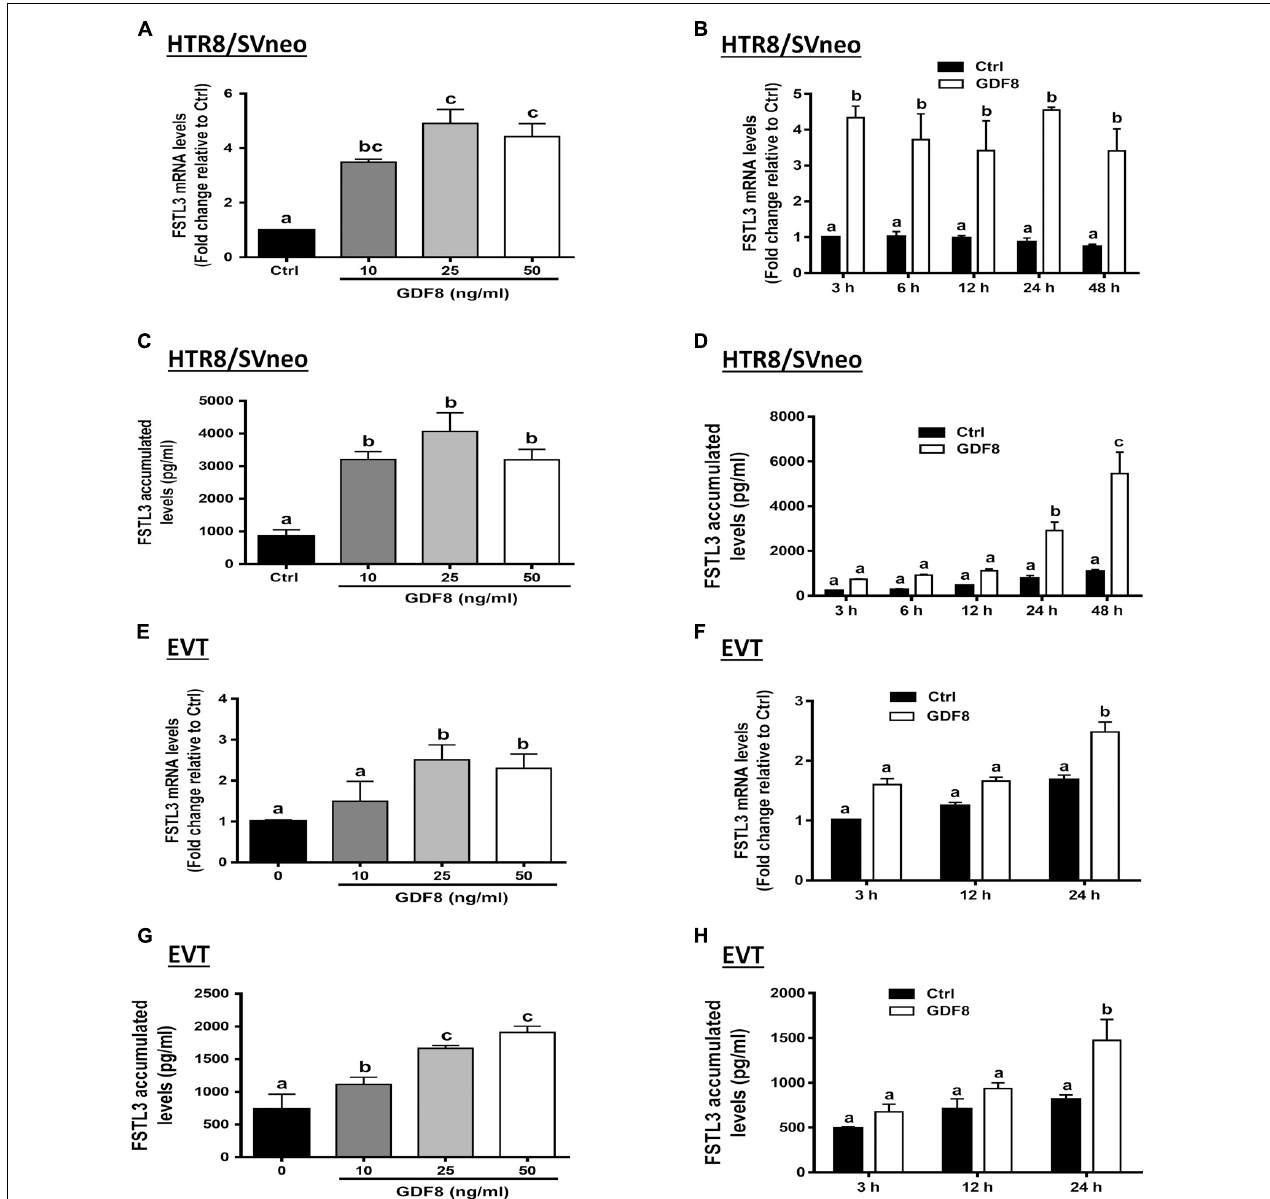
FIGURE 2 | Growth differentiation factor 8 (GDF8) upregulates the expression of follistatin-like 3 (FSTL3) in HTR8/SVneo and primary EVT cells. A,C,E, and G: HTR8/SVneo (A,C) or primary EVT (E,G) cells were treated for 24 h with the vehicle control (Ctrl) or different concentrations (10, 25, or 50 ng/mL) of GDF8; the mRNA (A,E) and accumulated (C,G) levels of FSTL3 were examined using RT-qPCR and ELISA, respectively. B, D, F , and H: HTR8/SVneo (B,D) or primary EVT (F,H) cells were treated with the vehicle control (Ctrl) or 25 ng/mL GDF8 for 3, 6, 12, 24, or 48 h; the mRNA (B,F) and accumulated (D,H) levels of FSTL3 were examined using RT-qPCR and ELISA, respectively. The results are displayed as the mean ± SEM of at least three independent experiments, and the values with different letters are significantly different ( P <